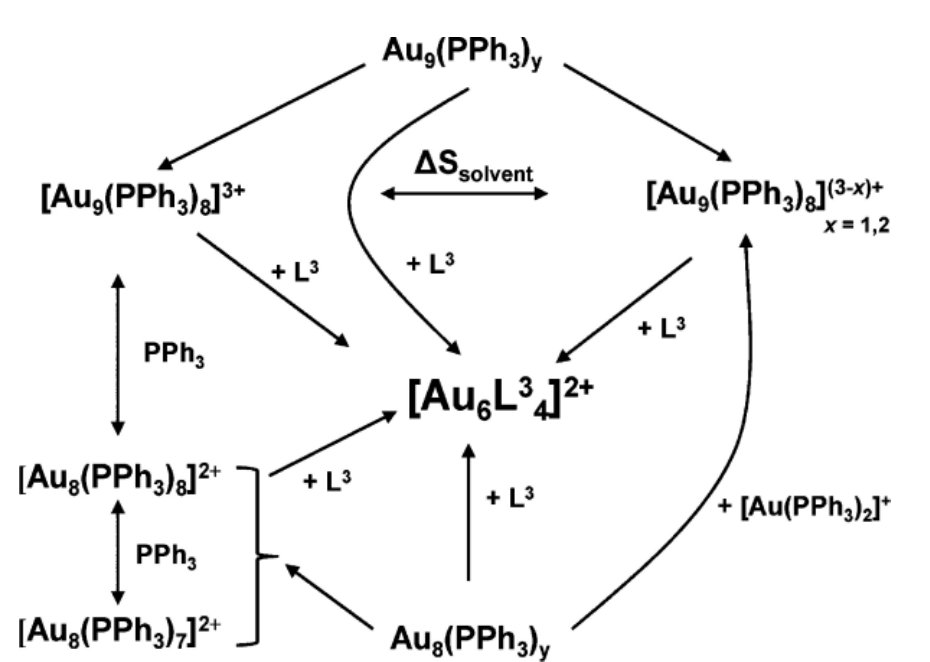
Figure 8. Conversion of Au NCs synthesized with PPh 3 as ligand under phosphine etchants. Reprinted with permission from Ref. [112]. Copyright © 2011 American Chemical Society.